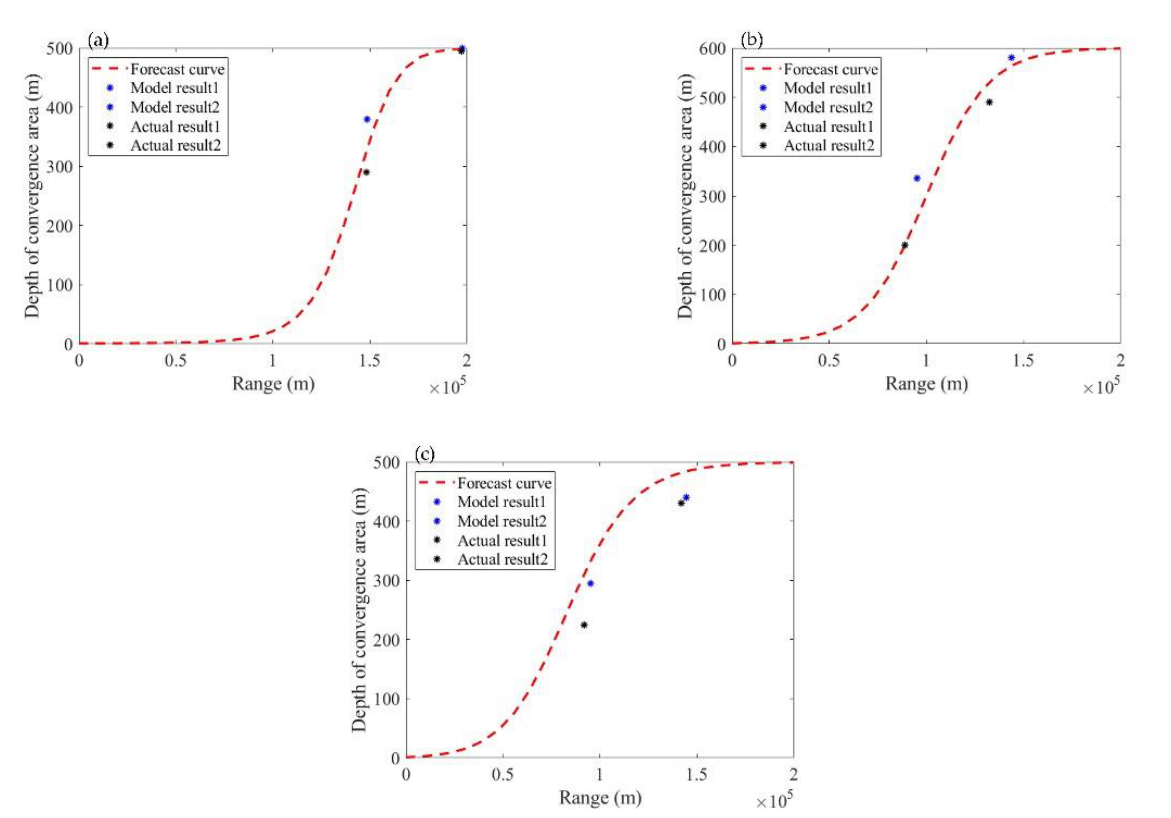
Figure 15. The forecasting curve of the depth of the convergence area and the calculating results of the model and actual ocean front (SD = 100 m): ( a ) 1 February; ( b ) 1 July; ( c ) 1 August. The forecasting results using the melt function based on the melt parameter a (which is related to the width and location of the frontal zone) were in good agreement with the model and the actual results, which proves the effectiveness of this method. It proves that the melt function was applied to effectively achieve the depth forecast of the convergence area in the ocean front environment.